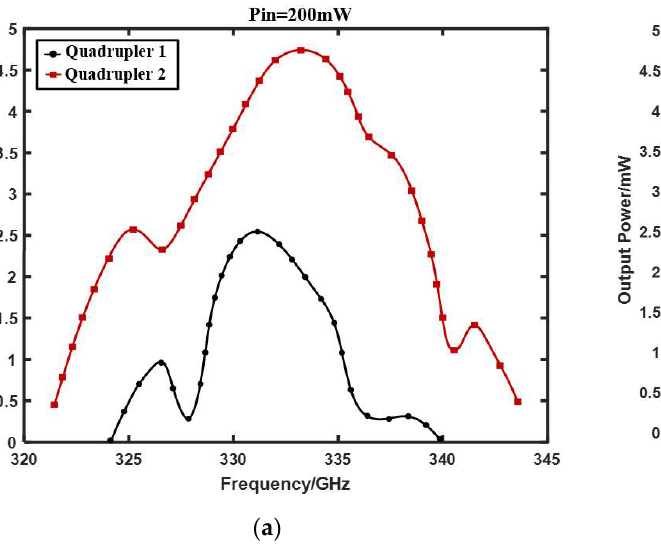
Figure 6. ( a ) Circuits in the quadrupler blocks; ( b ) photographs of the entire quadrupler modules. The test results are shown in Figure 8. Considering that the device could burn out due to excessive input power, the maximum input power of the quadrupler was fixed at 200 mW by adjusting the signal generator and the W-band power source. Due to the non- balanced circuit structure of the frequency multiplier, the efficiency is related to three var- iables: frequency, bias voltage, and input power. A comparison of the output power for the two 335 GHz quadruplers at 200 mW input power is shown in Figure 8a. The meas- ured output power of the Quadrupler 2 was more than 0.5 mW at 321–344 GHz, and the maximum output power was approximately 4.75 mW at 333 GHz. Compared with Quad- rupler 2, Quadrupler 1 had a narrower bandwidth with a maximum output power of 2.54 mw at 331 GHz. Figure 8b shows the relationship between the output power and bias voltage at 333 GHz for Quadrupler 1 and Quadrupler 2. The output power of the two quadruplers reached a maximum at bias voltages of −10.9 V and −10 V, respectively, and then began to decline. Figure 8c shows the efficiency versus input power at 333 GHz for Quadrupler 1 and Quadrupler 2. It can be seen that the efficiency increased with the in- crease in input power, until it reached the maximum at a certain input power and tended to be flat because the diode was close to saturation at this time. When the input power exceeded a certain value, the efficiency decreased with the increase in input power. The test results were basically consistent with the theoretical analysis. Based on the results in Figure 8c, the input power was adjusted to 120 mW, and the relationship between the efficiency and frequency of the two quadruplers is shown in Figure 8d. The results showed that Quadrupler 2 not only had a higher efficiency than Quadrupler 1, but also had a wider bandwidth. Figure 7. Test diagram of the 335 GHz quadrupler.